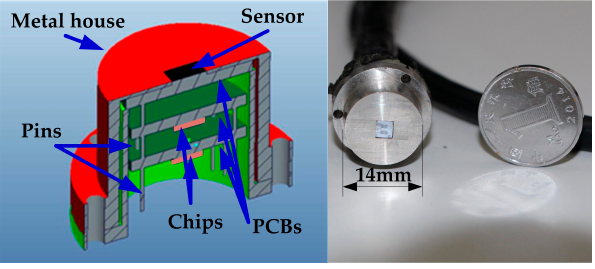
Figure 5. Package of the micro-sensor with backside connections and the picture of packaged sensor probe.